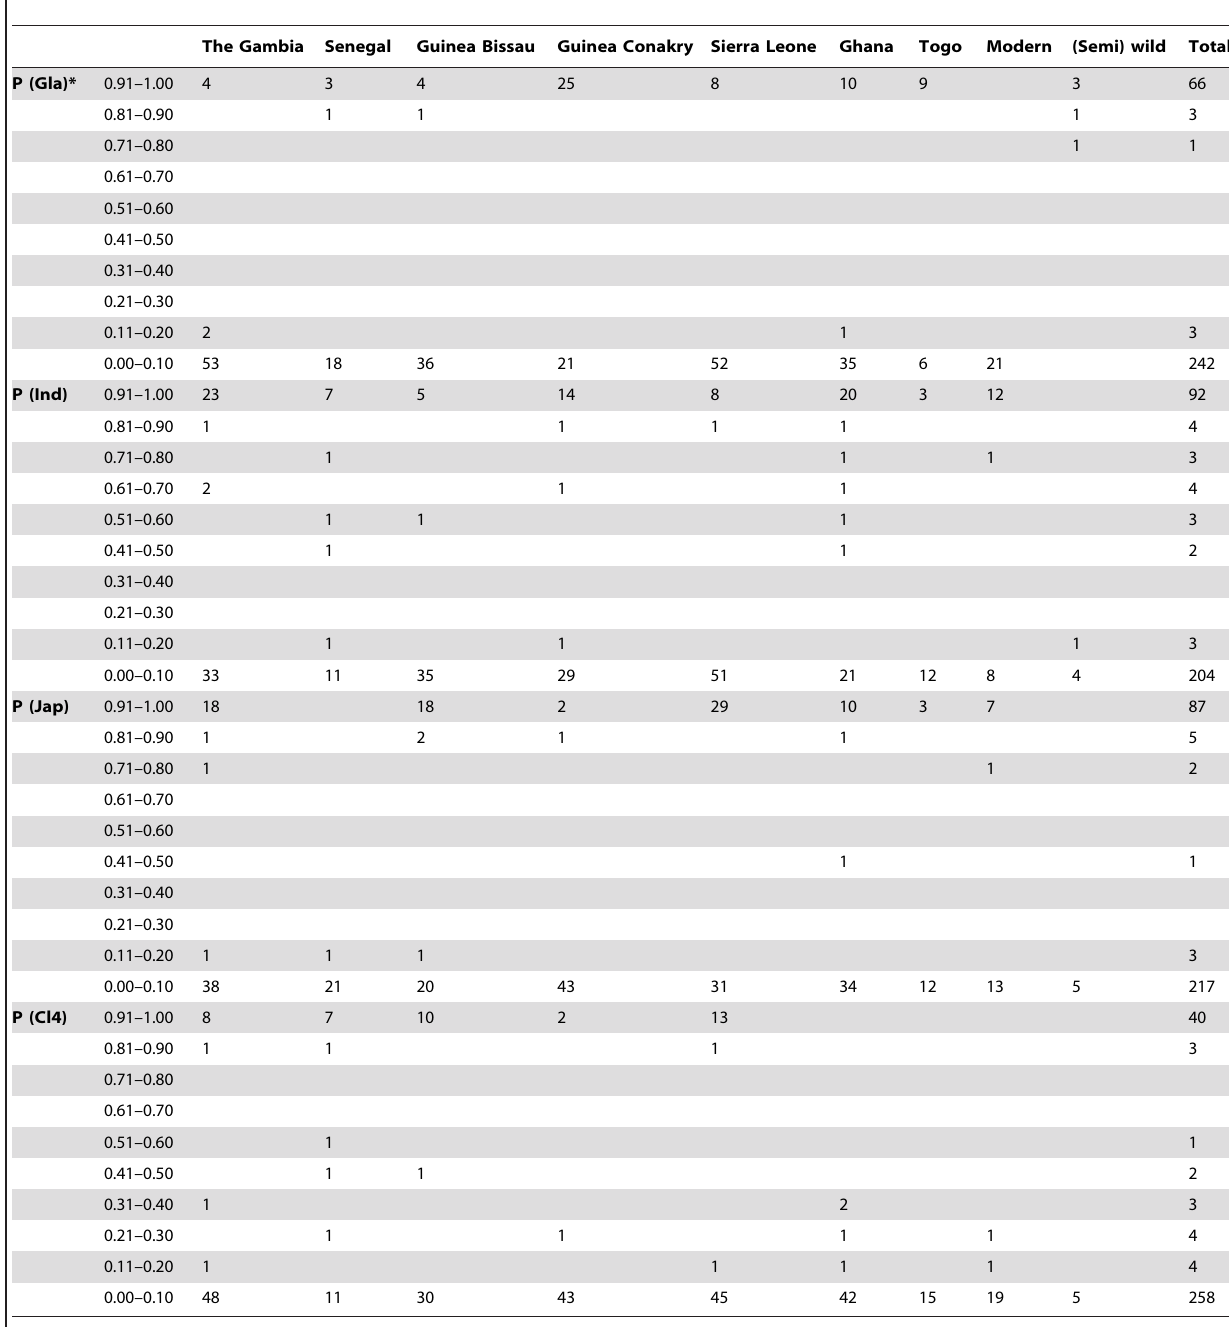
Table 4. Number of farmer varieties, modern varieties and (semi-) wild relatives assigned by the software ‘Structure’ to the four observed